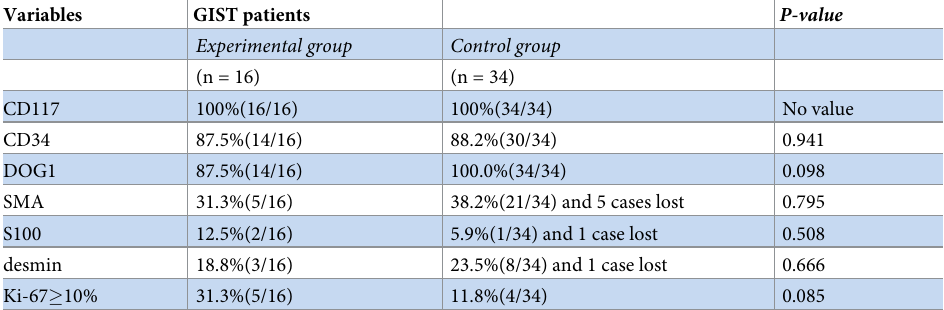
Table 3. Immunohistochemical characteristics of GIST patients in the experimental group and control